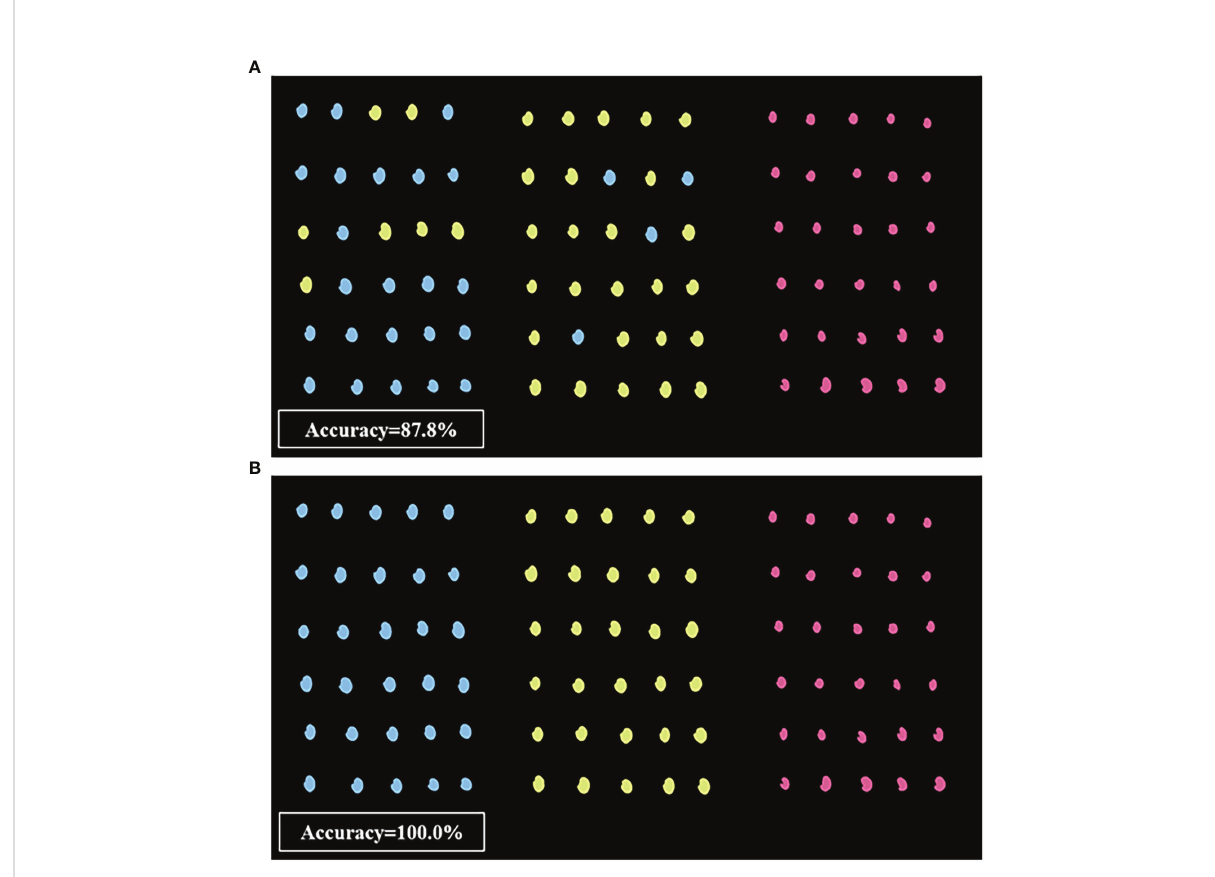
FIGURE 8 Visualization results based on (A) machine vision optimal model and (B) HSI optimal model (from left to right: AMM, AM, and SM